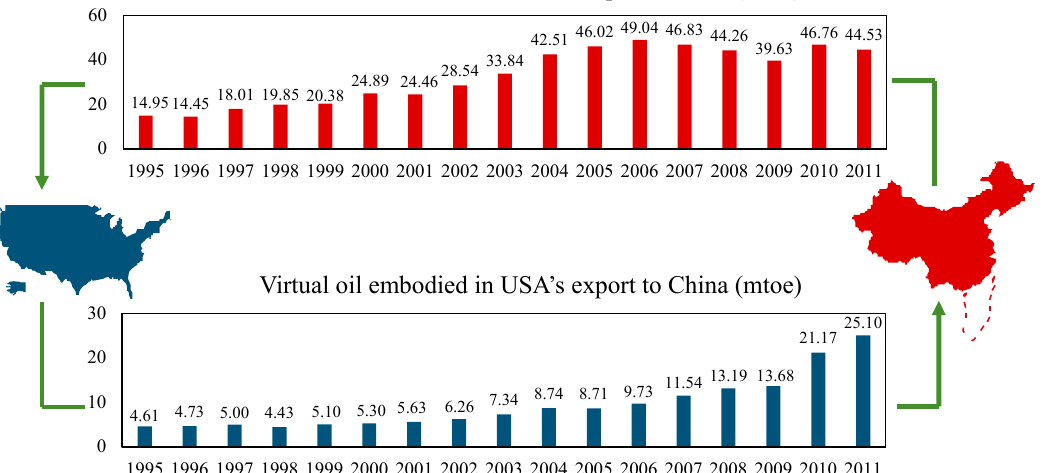
Figure 4. The evolution of the USA’s virtual oil consumption: ( a ) Exports; ( b ) Imports.